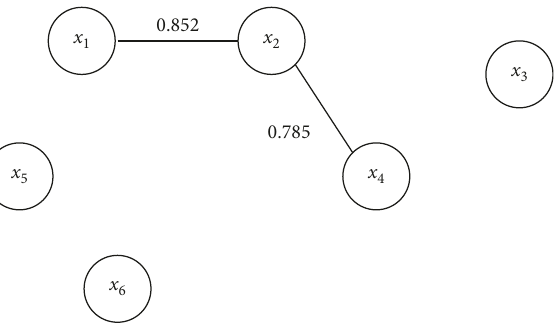
Figure 6: The tree after further pruning.